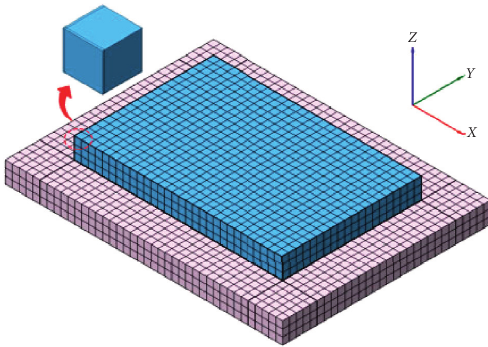
Figure 2: Mesh generation of the